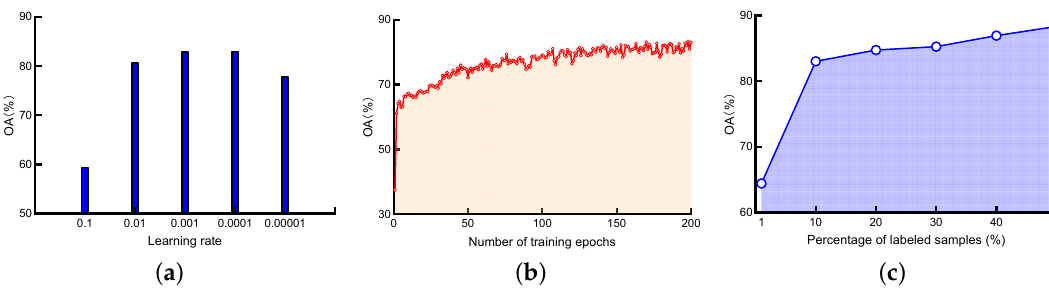
Figure 13. Impact of the ( a ) initial learning rate, ( b ) number of training epochs and ( c ) number of labeled training samples on the overall accuracy